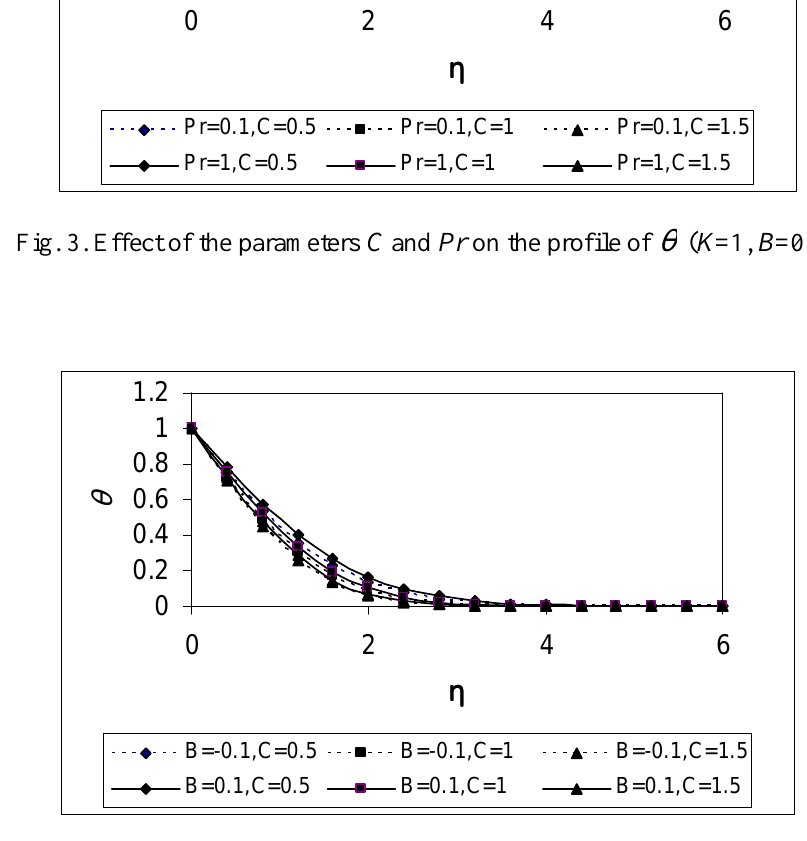
Fig. 4. Effect of the parameters C and B on the profile of q ( K =1, Pr =0.7)